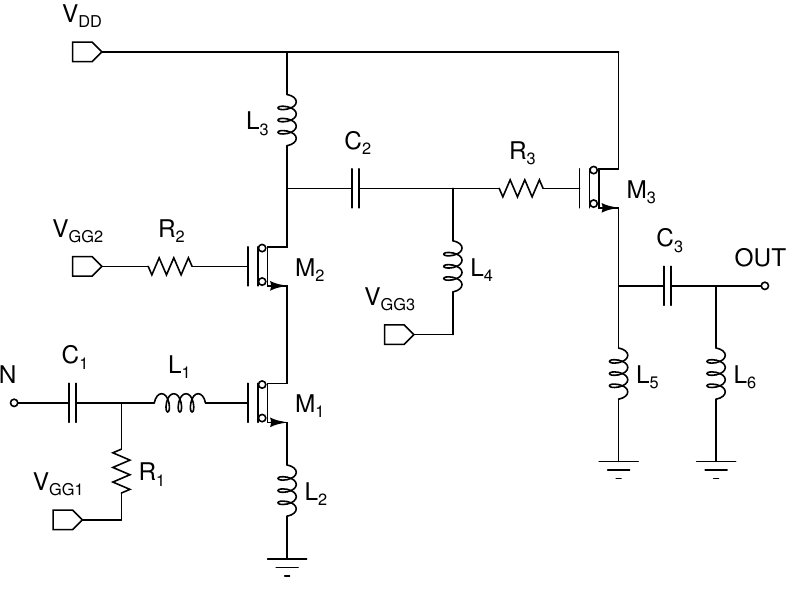
Figure 7. Schematic of the cascode—common-drain CNT-FET low-noise amplifier. The CNT-FETs M 1 and M 2 of the first stage are chosen with the same channel width W = 100 µm and channel length L = 200 nm. For the second stage, an M3 transistor of W = 400 µm and L = 200 nm was chosen. The power supply is designed to be a 1.5 V. The input-matching network was designed by adding the series of C 1 and L 1 to match the 50 Ω resistance. The resistors R 1 provides the DC gate bias for M 1 . The interstage matching